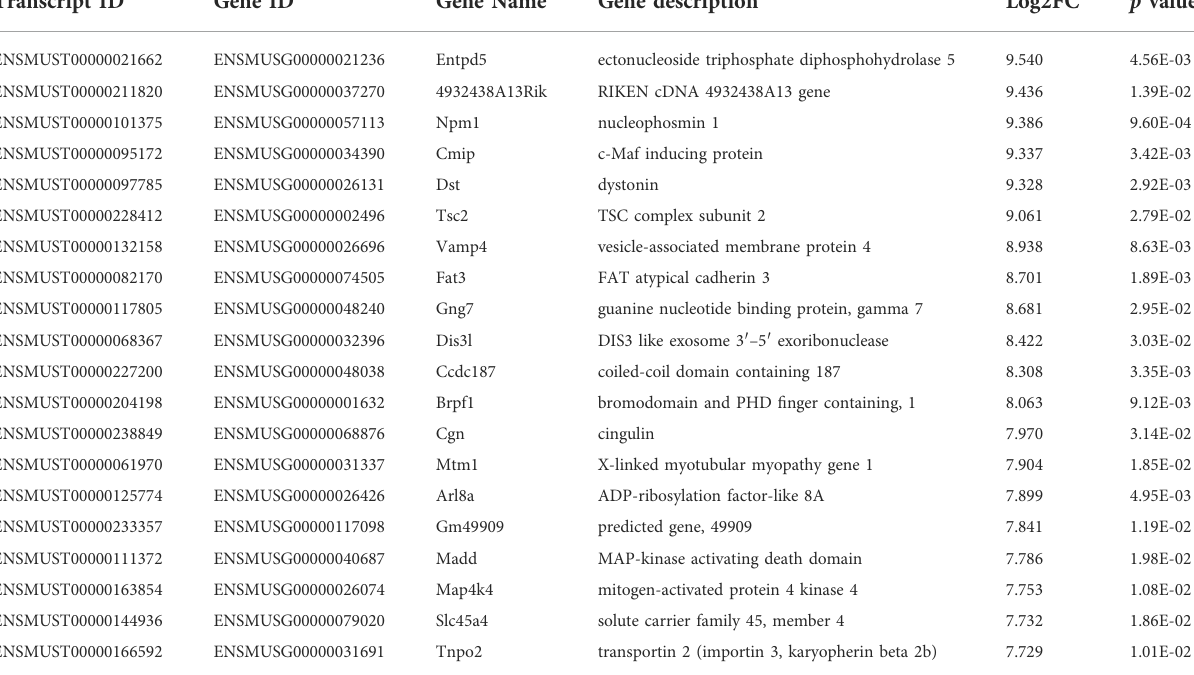
TABLE 3 Top 20 upregulated mRNA ( p < 0.05) between FDM and fellow groups.